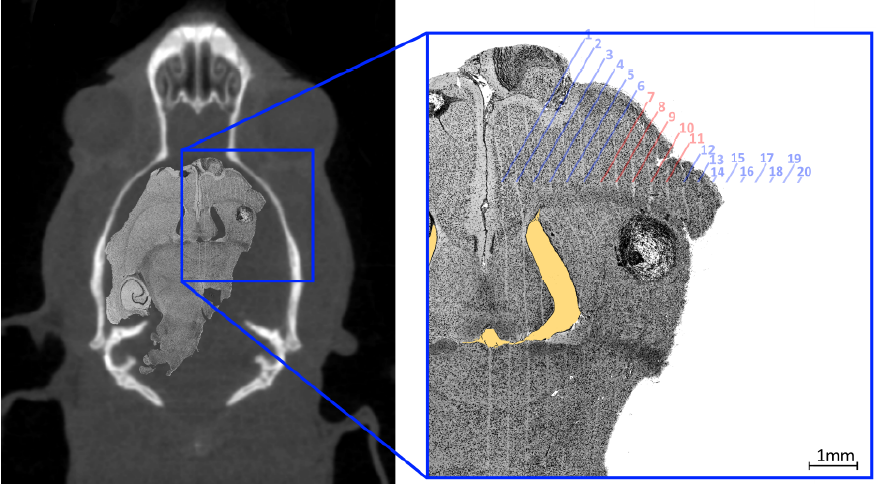
Figure 10. Composite image with a histology slide overlaid on corresponding coronal CT slice of tumour-bearing rat, 14 days after MRT treatment ( left ). The enlarged image ( right ) shows a tumour situated within the MRT treatment field (parallel vertical lines) with microbeams present and expected numbered with red text identifying the microbeams that transit the tumour mass (dark circular object at the centre of the frame). The yellow shaded region highlights a void in the brain material caused by manual handling of the fragile